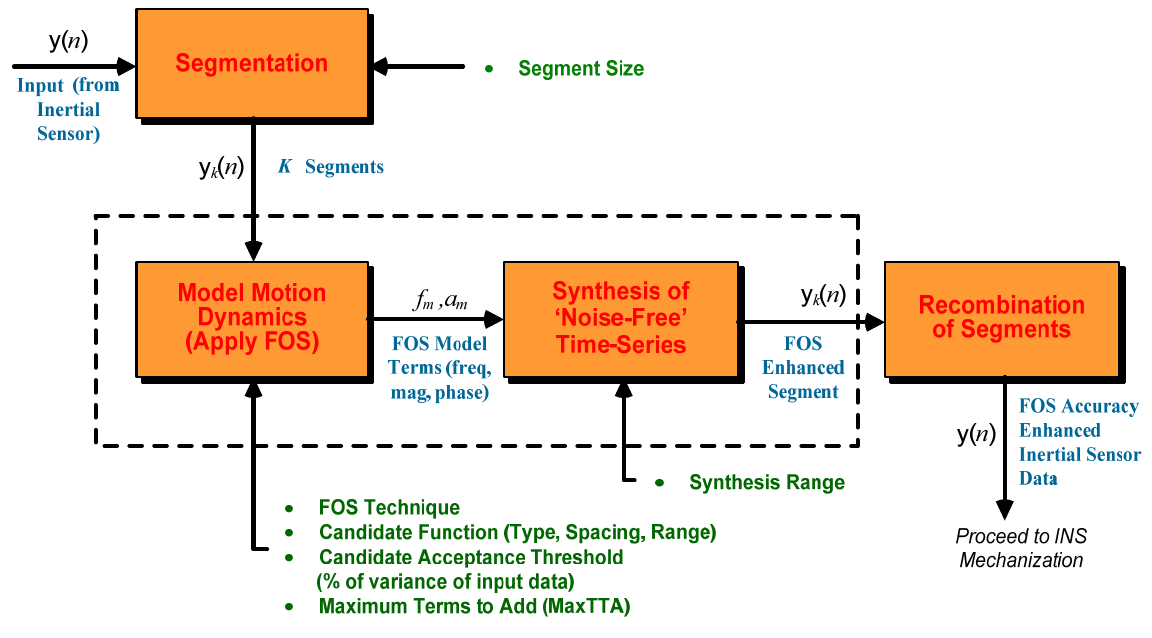
Figure 1. Block diagram of FOS-based inertial sensor accuracy enhancement technique (bullets denote operating